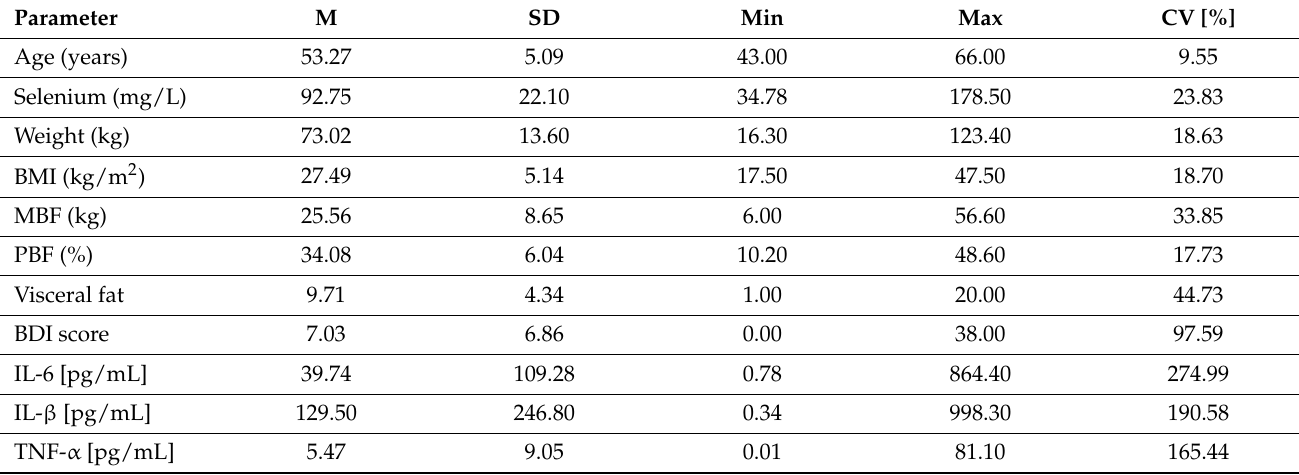
Table 2. Characteristics of the study sample ( N =